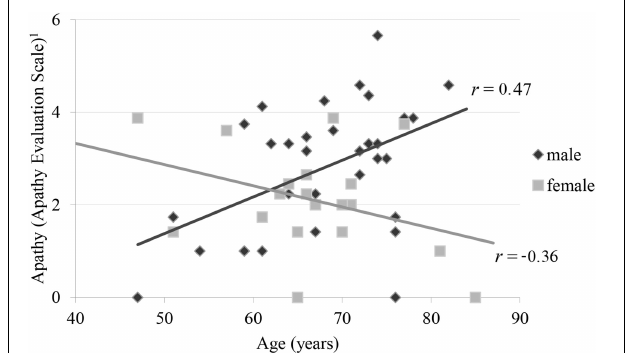
FIGURE 1 | Correlation of apathy and age by gender 1 Apathy Evaluation Scale represents root transformed